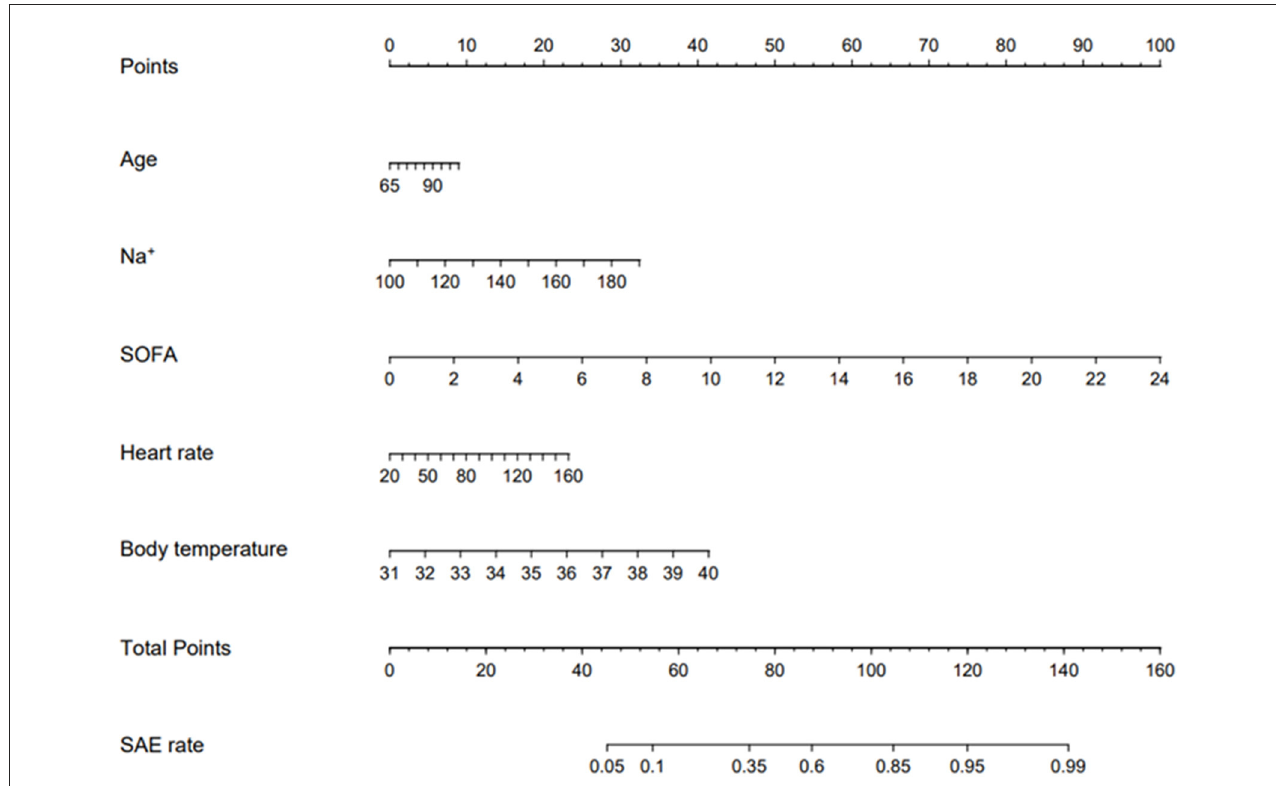
FIGURE3 Validated nomogram for predicting 30-day mortality of SAE. When using it, drawing a vertical line from each variables upward to the points and then recording the corresponding points (i.e., “SOFA = 10” = 40 points). The point of each variable was then summed up to obtain a total points that corresponds to a predicted probability of SAE at the bottom of the nomogram.